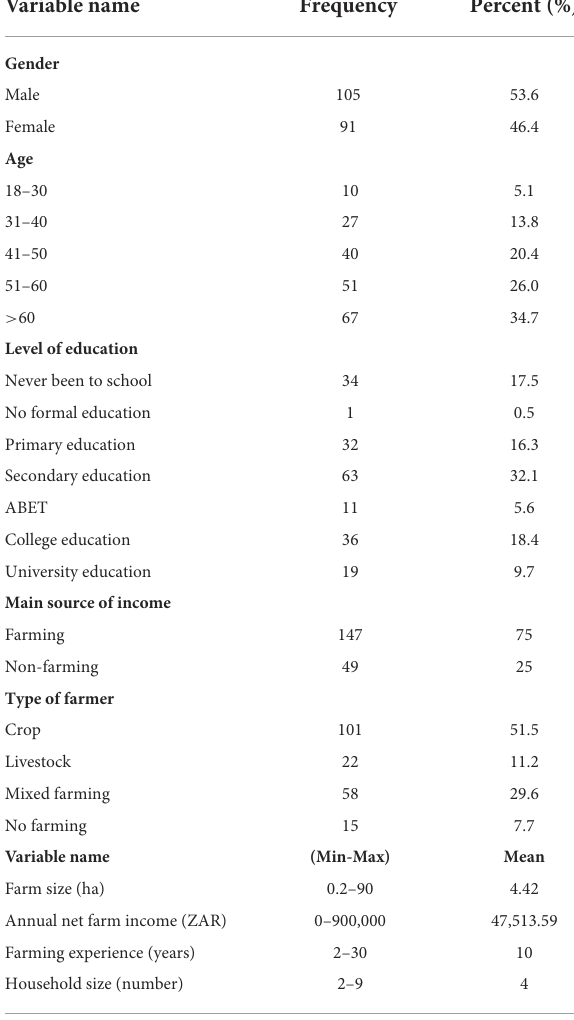
TABLE 2 Socio-demographic characteristics of the participants ( n = 196).